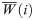
Notional Diagram.This diagram depicts three distinct regions in NxE parameter space of the model. Region I exhibits a moderate switching rate, high degrees of order, θ, and average agent wealths, W¯(i). Region II has a lower switching rate but also a lower order and average wealth than region I. Region III has a high switching rate and order and average wealth near zero.